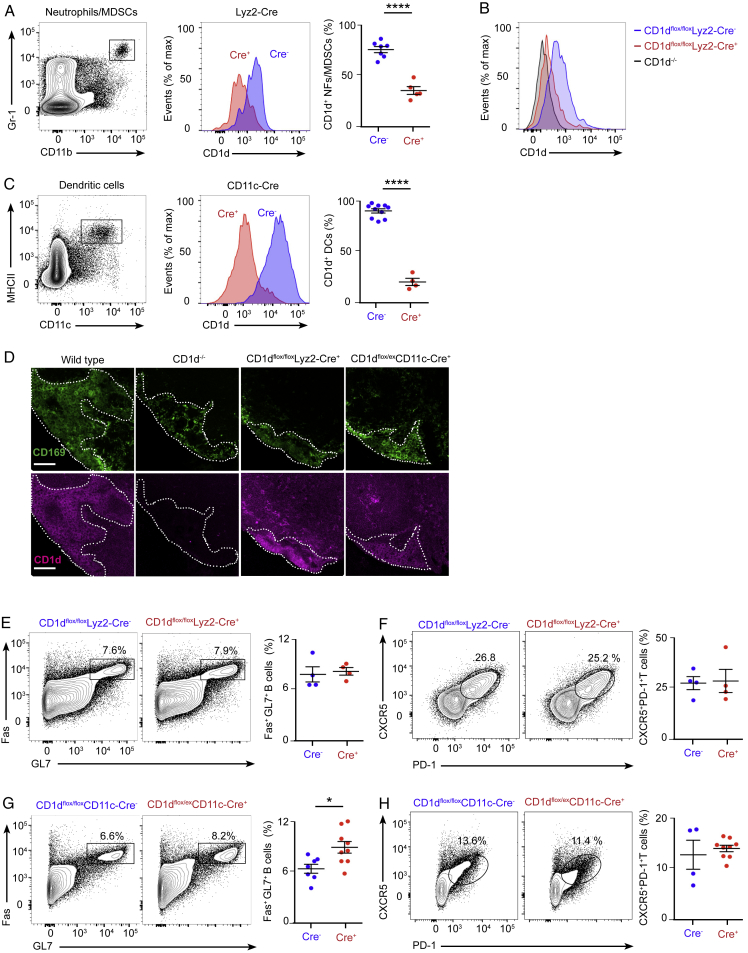
Conditional Targeting of CD1d in the Myeloid Lineage, Related to Figure 5(A–C) Flow cytometry plots showing the gating strategy for (A) Gr-1+CD11b+ neutrophils (NFs) and myeloid-derived suppressor cells (MDSCs) and (C) MHCII+CD11c+ dendritic cells (DCs). Red and blue histograms depict the levels of CD1d in the gated populations in (A) CD1dflox/floxLyz2-Cre- versus Cre+ and (B) CD1d−/− mice or (C) CD1dflox/exCD11c-Cre- versus Cre+ mice. These quantitative differences are depicted via dot plots; blue and red dots show CD1d+ cells in the Cre- and Cre+ animals, respectively.(D) Confocal microscopy of mediastinal lymph nodes sections from wild type, CD1d−/−, CD1dflox/floxLyz2-Cre+ and CD1dflox/exCD11c-Cre mice. Sections were stained with antibodies to CD169 (green) and CD1d (magenta). Scale bars, 60 μm.(E–H) Flow cytometry analysis of mediastinal lymph node cells at day 9 of influenza infection. Representative contour plots show the percentage of B cells and T cells from (E-F) CD1dflox/floxLyz2-Cre- and Cre+ or (G-H) CD1dflox/exCD11c-Cre- and Cre+ mice that acquire (E and G) germinal center markers, Fas and GL7, or (F and H) TfH cell markers, CXCR5 and PD-1. Quantifications are shown in dot plots, Cre- mice (blue dots) and Cre+ mice (red dots).In all panels, each dot represents a single mouse. Horizontal bars – mean; error bars – SEM. Data are representative of three independent experiments. Statistical analysis, two tailed Student’s t test, ∗p < 0.05, ∗∗∗∗p < 0.0001.